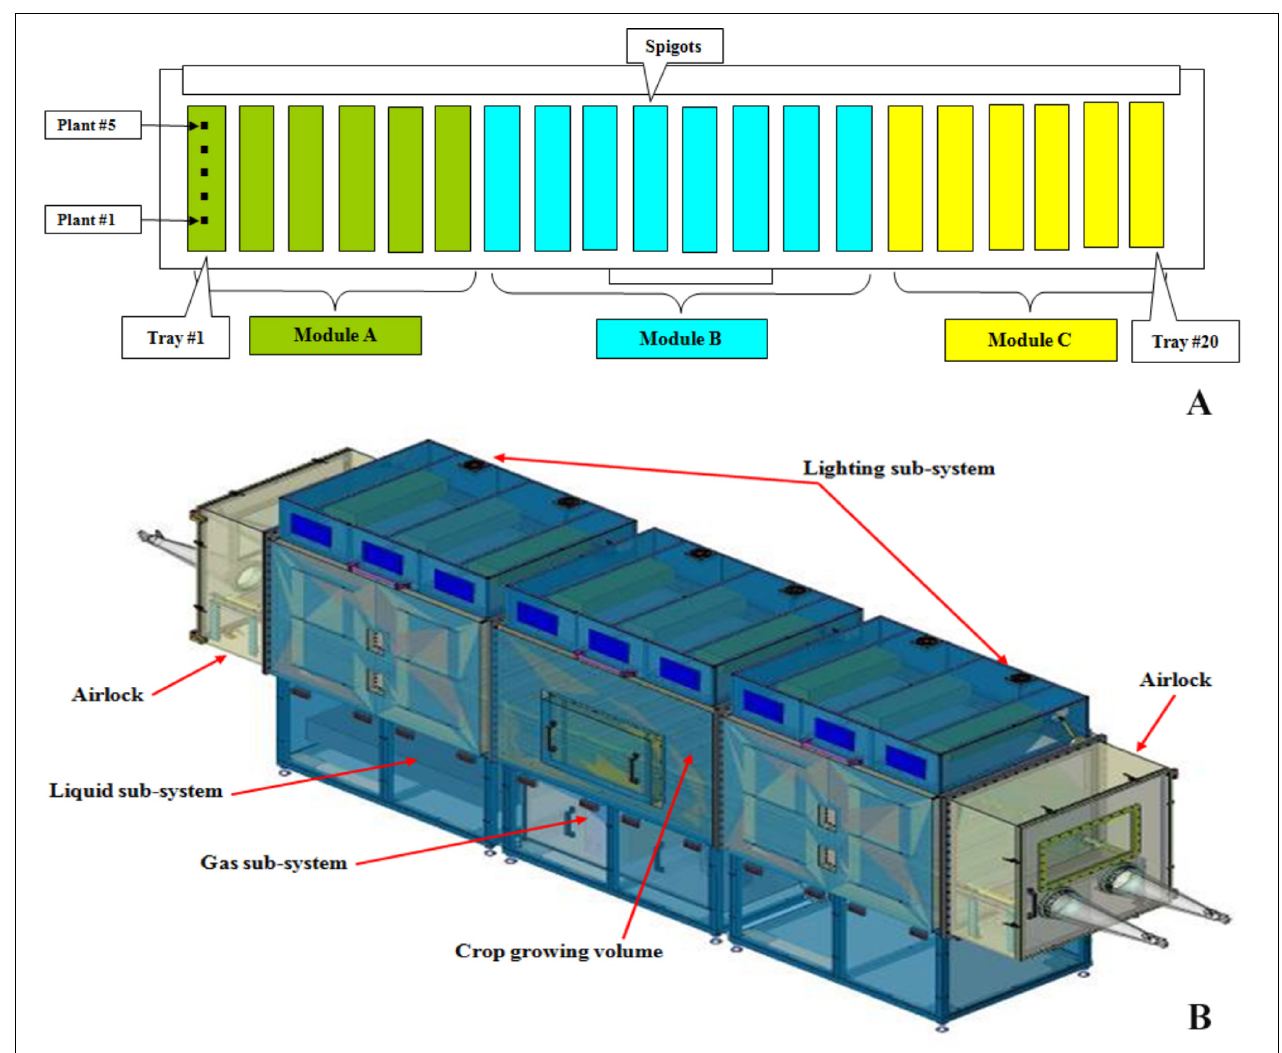
FIGURE 1 | Schematic top view of the growth chamber with plants location and trays numbering (A) and hardware representation of the Higher Plant Compartment of MELiSSA Pilot Plant Facilities (B)